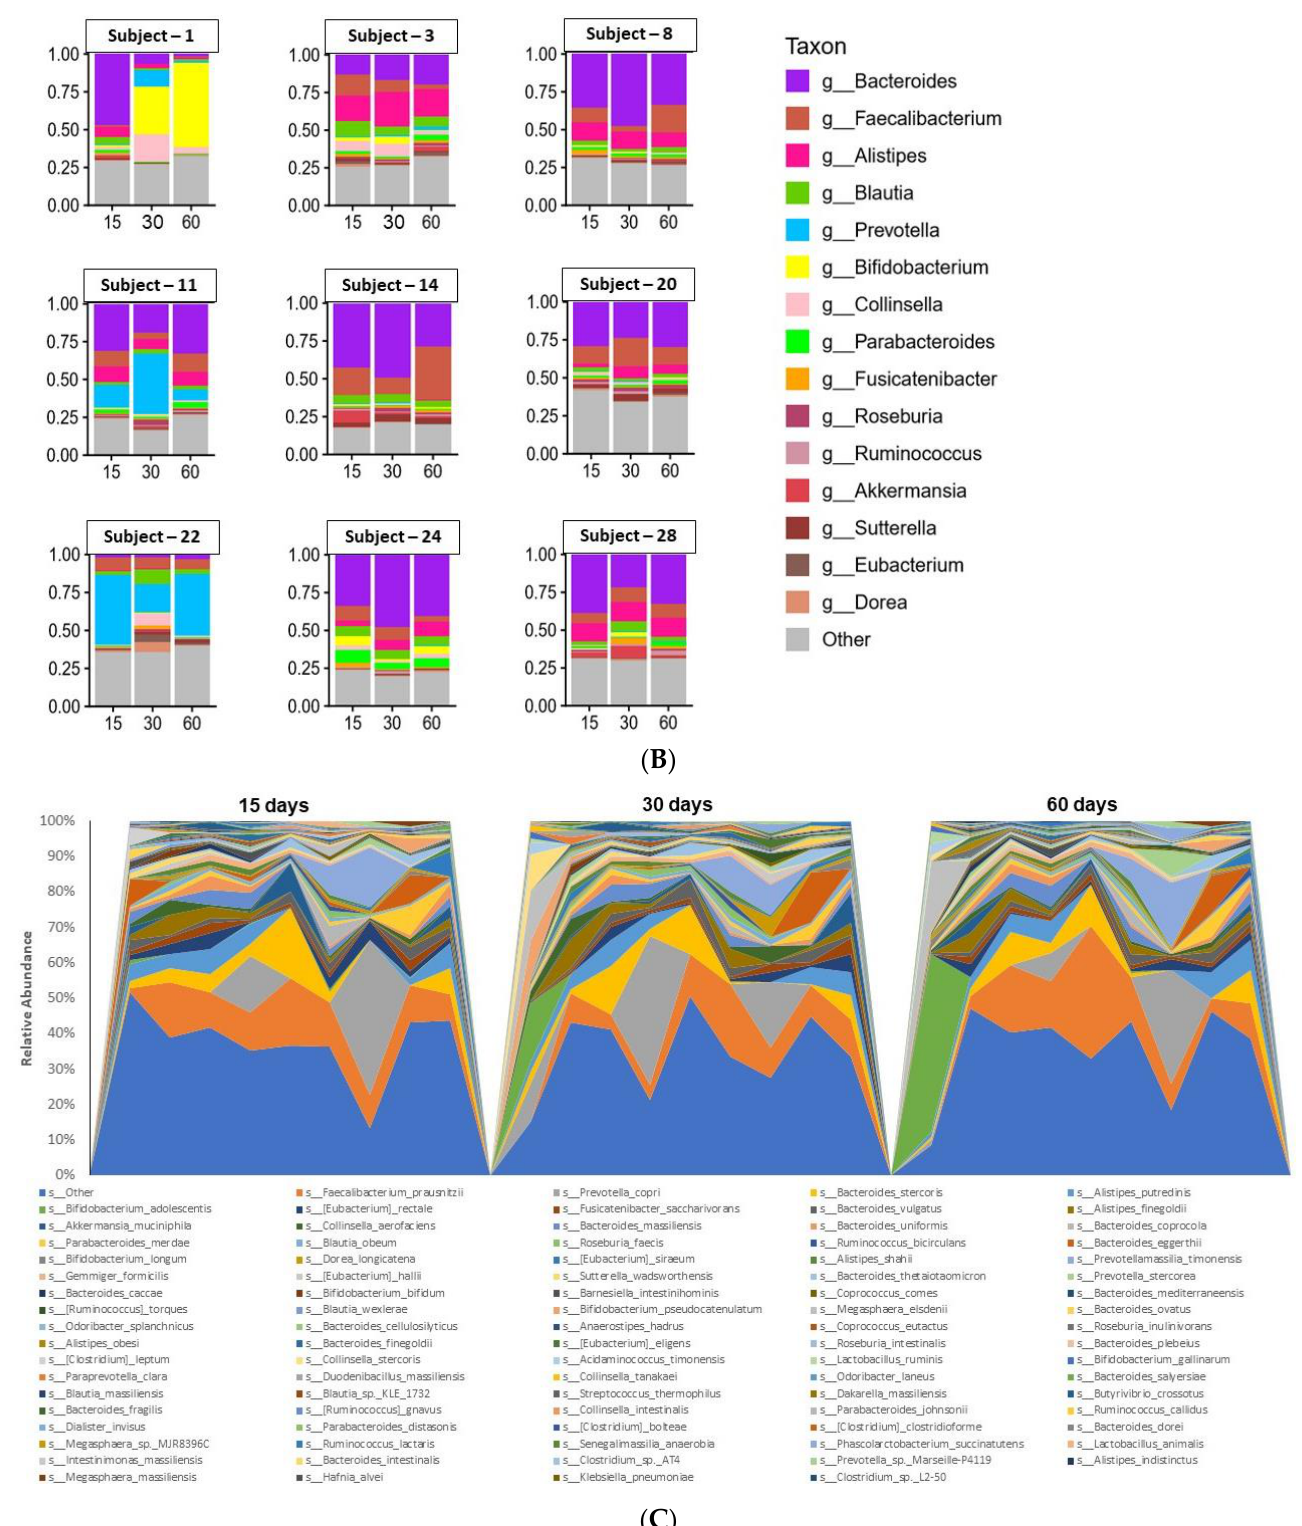
Figure 2. Stack plots illustrating the quantitative distribution of microbial species ( A ) and genus ( B ) of the subjects demonstrating greater resistance to UV irradiation ( n = 9) on Days 15, 30 and 60. Area charts illustrating the same data are also presented ( C ). Subjects are listed by number in Table 1.